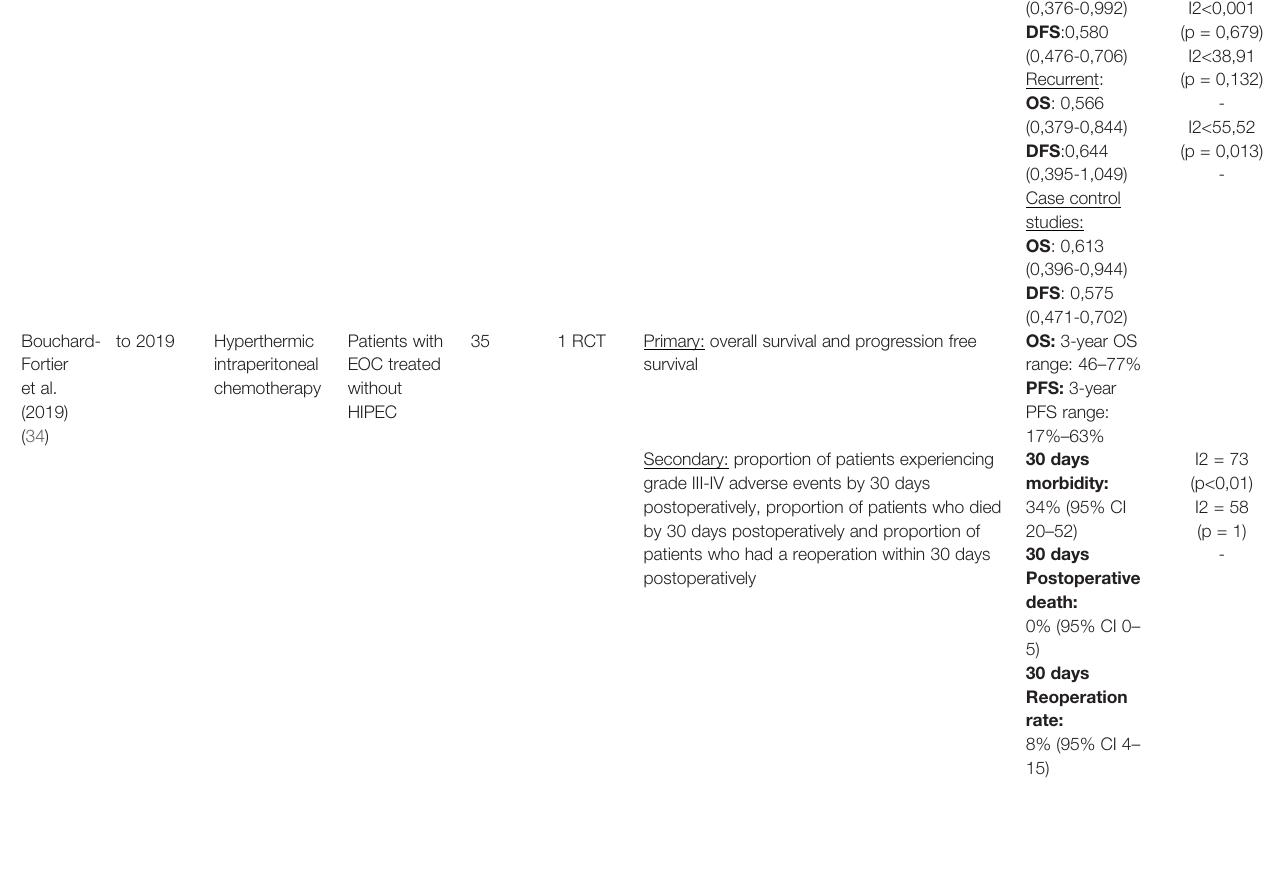
Subgroup analysis: effect of HIPEC for primary or recurrent disease and in case control